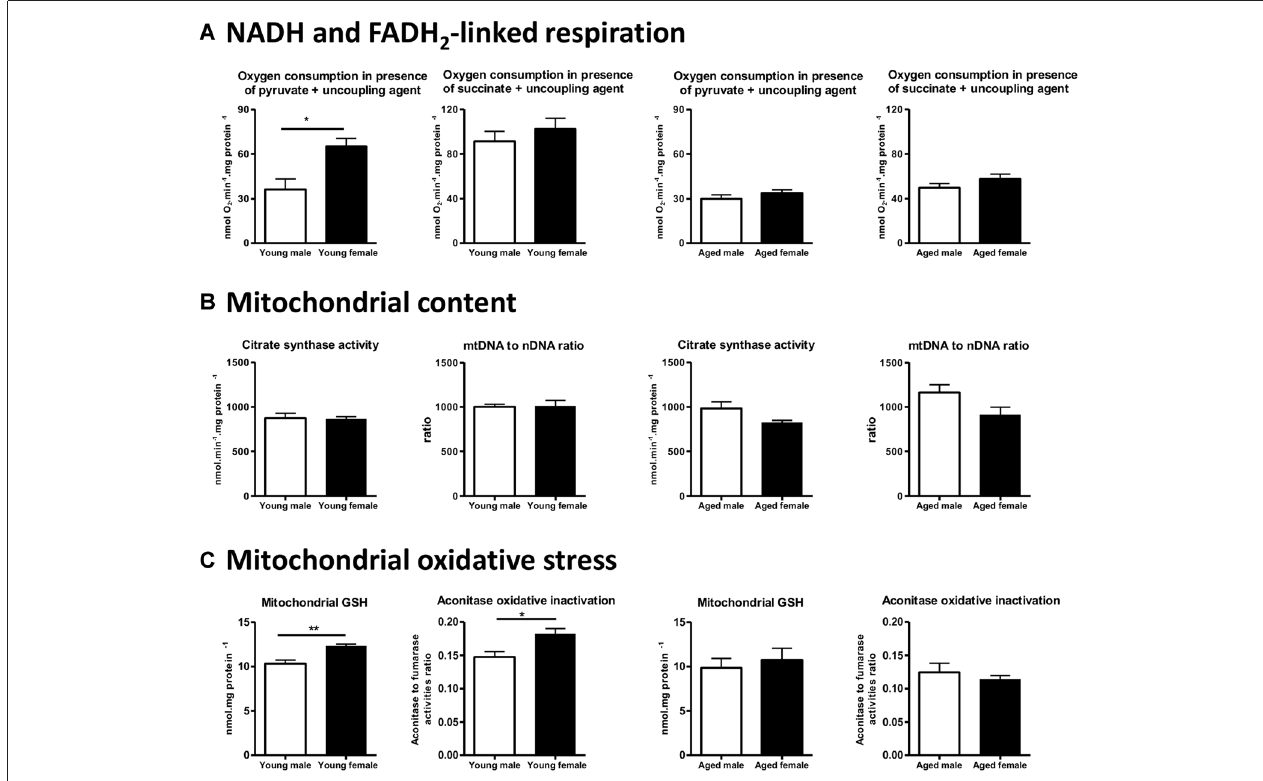
FIGURE 4 | Sex differences in brain mitochondrial metabolism in young (3-month-old) and aged (20-month-old) male and female mice. (A) NADH-linked respiration rate (measured by the oxygen consumption in presence of pyruvate) was higher in young females (diestrus stage) than in young males and this sex difference disappeared in aged mice. (B) Mitochondrial content estimated by the citrate synthase activity and the mtDNA to nDNA ratio was not different between males and females in both young and aged mice. (C) Mitochondrial GSH pool was higher and oxidative inactivation of aconitase was lower in young females than in young males. These differences did not persist in aged mice. Data represent mean ± SEM of 5–6 mice. Statistical analysis: t -test. Significance: ∗ p < 0.05; ∗∗ p < 0.01. mtDNA, mitochondrial DNA; nDNA, nuclear DNA; GSH, reduced glutathione. Data from Gaignard et al. (2015).